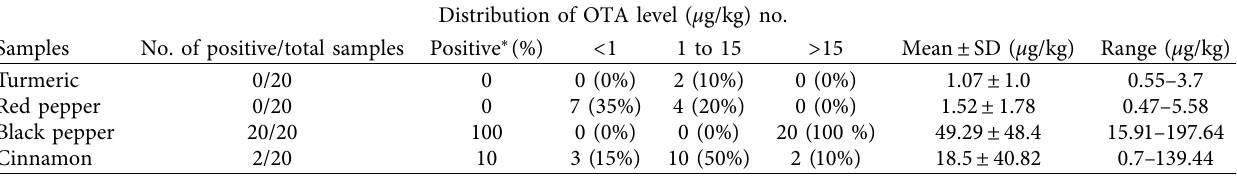
Table 3: Concentration distribution of OTA. Distribution of OTA level ( μ g/kg)